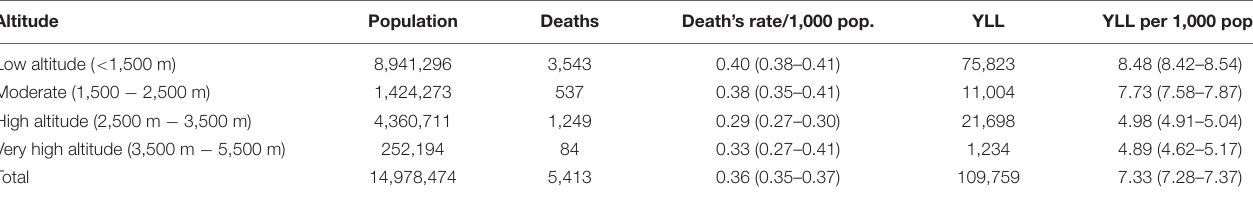
FIGURE 6 | Cumulative risk for mortality and hospital admissions in men and women living at four different elevation in Ecuador from 2001 to 2017. Low altitude was used as a reference variable. TABLE 3 | Burden of stroke and years of life lost (YLL) prematurely due to stroke in Ecuador from 2001 to 2017. Altitude Population Deaths Death’s rate/1,000 pop. YLL YLL per 1,000